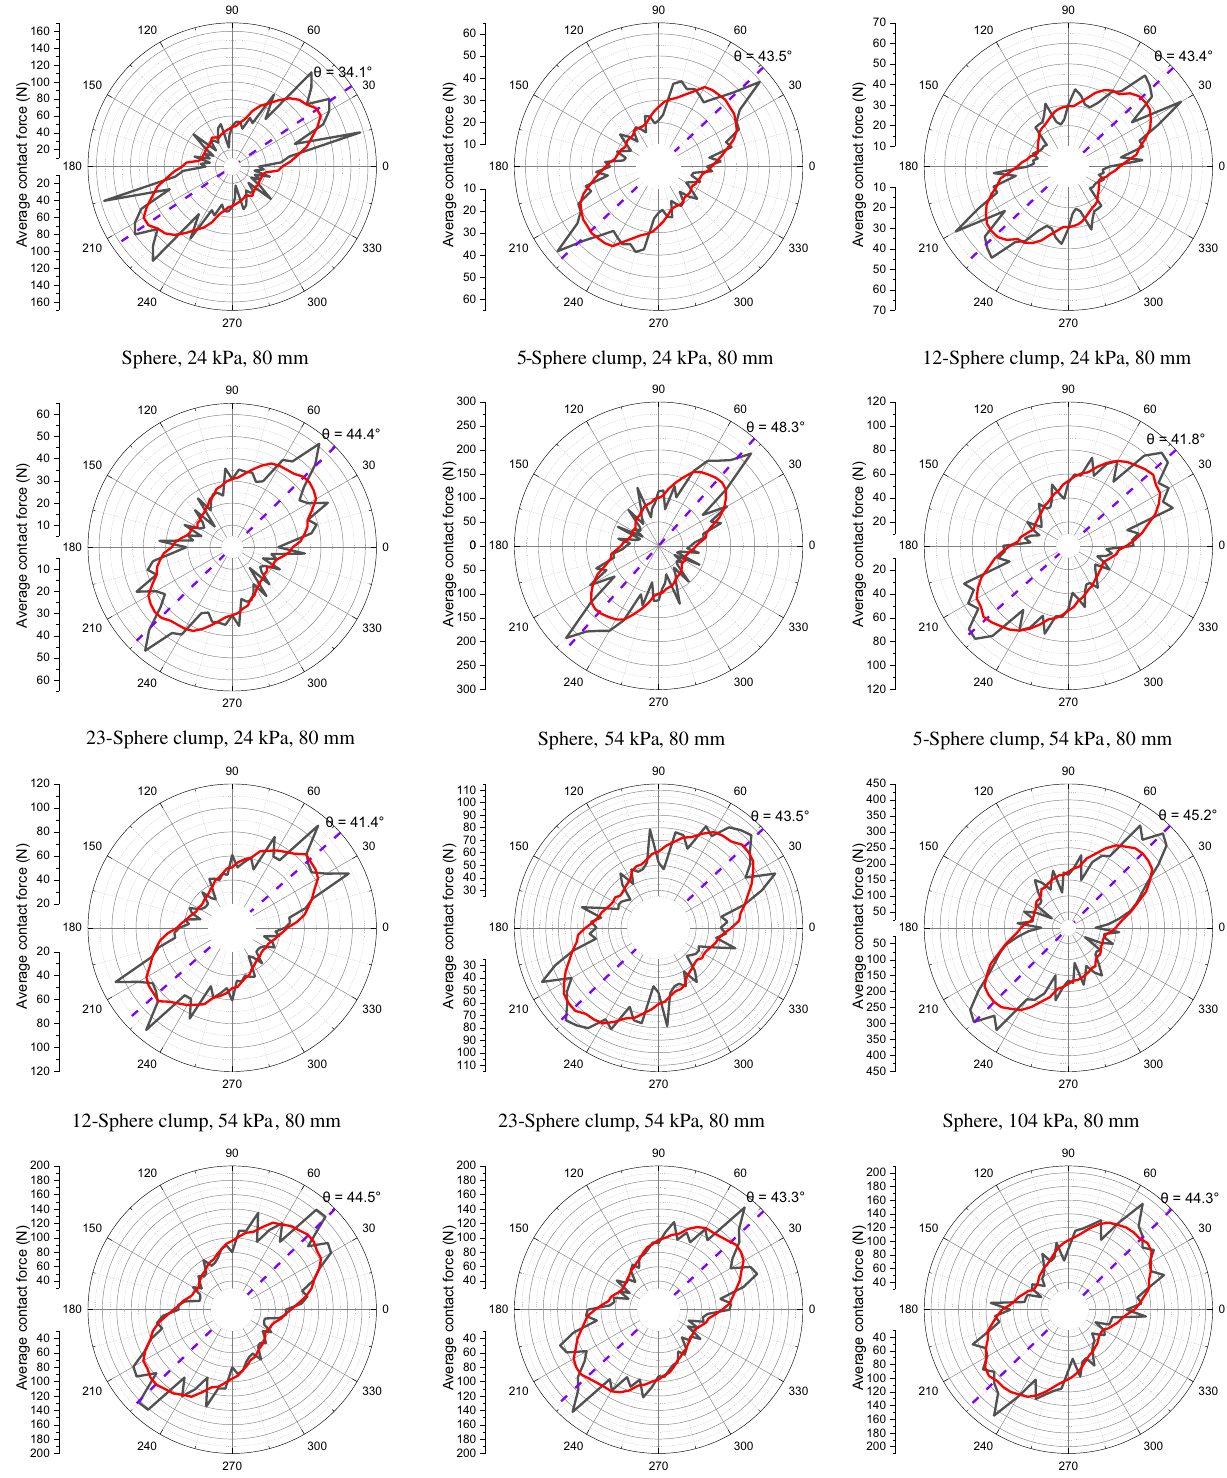
Fig. 15 Distributions of the particle contact